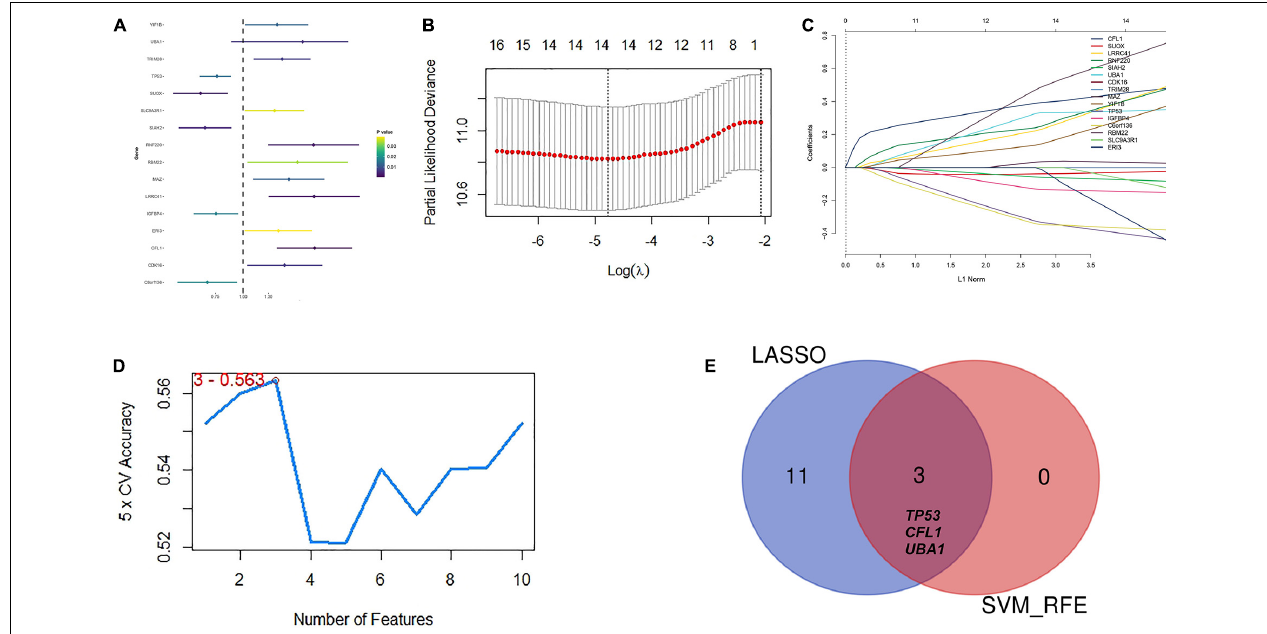
FIGURE 4 | Identification of candidate hub genes to predict prognosis for HBV carriers with HCC development. (A) Univariate COX regression of the 128 previously screened variables in the TCGA training cohort ( n = 93). (B) Partial likelihood deviance of different numbers of variables revealed by the LASSO regression model. The red dots represent the partial likelihood deviance values. The gray lines represent the partial likelihood deviance ± standard error (SE). (C) LASSO regression with tenfold cross-validation obtained 14 candidate genes with minimum lambda value. (D) Candidate genes filtrated from SVM-RFE algorithms. (E) A Venn diagram to display the overlapped 3 optimal hub genes between LASSO and SVM-RFE algorithm. LASSO, least absolute shrinkage and selection operator method; SVM-RFE, support vector machine recursive feature elimination.